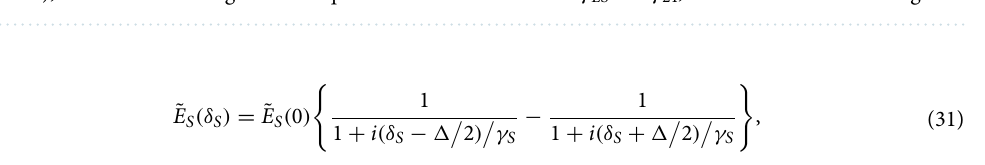
Figure 7. (Color online) Waveform of the SMS Lorentz-squared photon [the green dotted curves, Eq. (34)] transmitted through the motionless absorber (dotted black curves) and the vibrating absorber at ϑ 2 (in red), and averaged over ϑ (in brown). All are plotted as the normalized function I ϑ π = ( 8 π) ] according to Eq. (12) with (cid:31) T inset in (c) . Each component of the spectral doublet (Eq. 31) with splitting � (see text), so that the resulting Lorentz-squared SMS line has a width γ LS